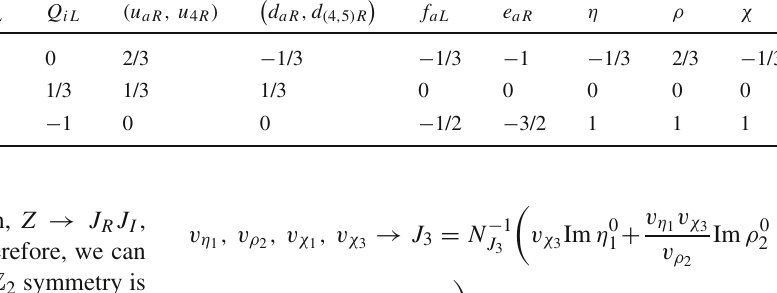
Table 1 The U ( 1 )